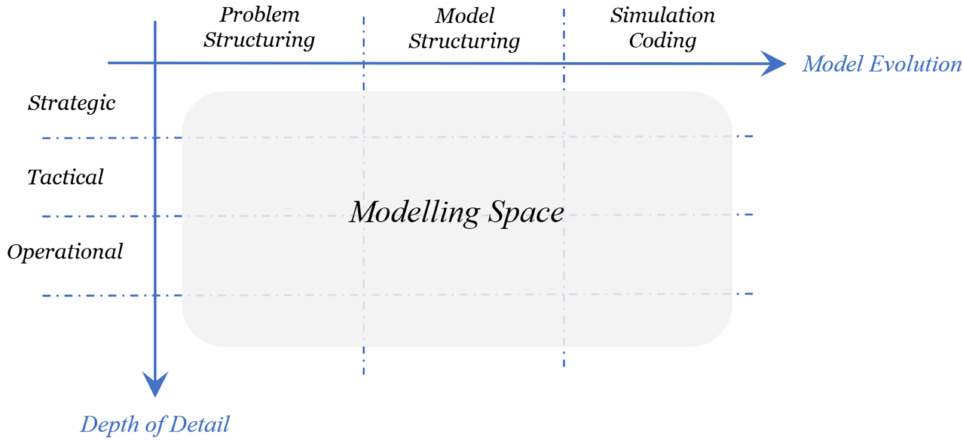
Figure 3. Modelling Space as the set of choices to be made during the development of the model.